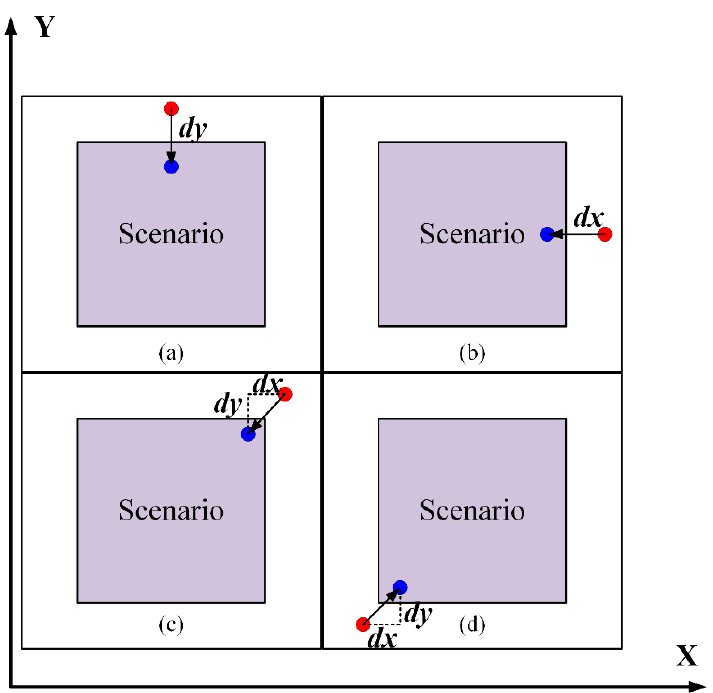
Figure 4. The schematic diagram of the position constraint: ( a , b ) show the situations when the X and Y coordinates of positioning result are beyond the maximum X and Y values, respectively; ( c , d ) present the cases in which the X and Y coordinates are greater than and less than the maximum and minimum of the boundary, respectively.